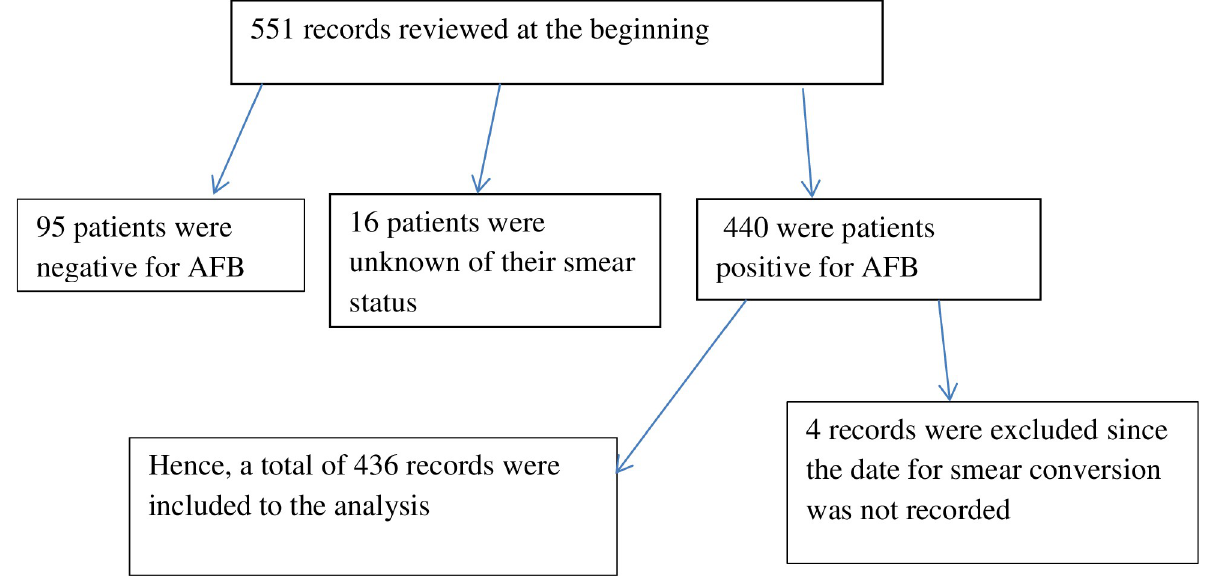
Fig 1. The diagrammatic presentation showing a selection of DR-TB patients in Amhara Regional State Public Hospitals from September 2010 to December 2017.